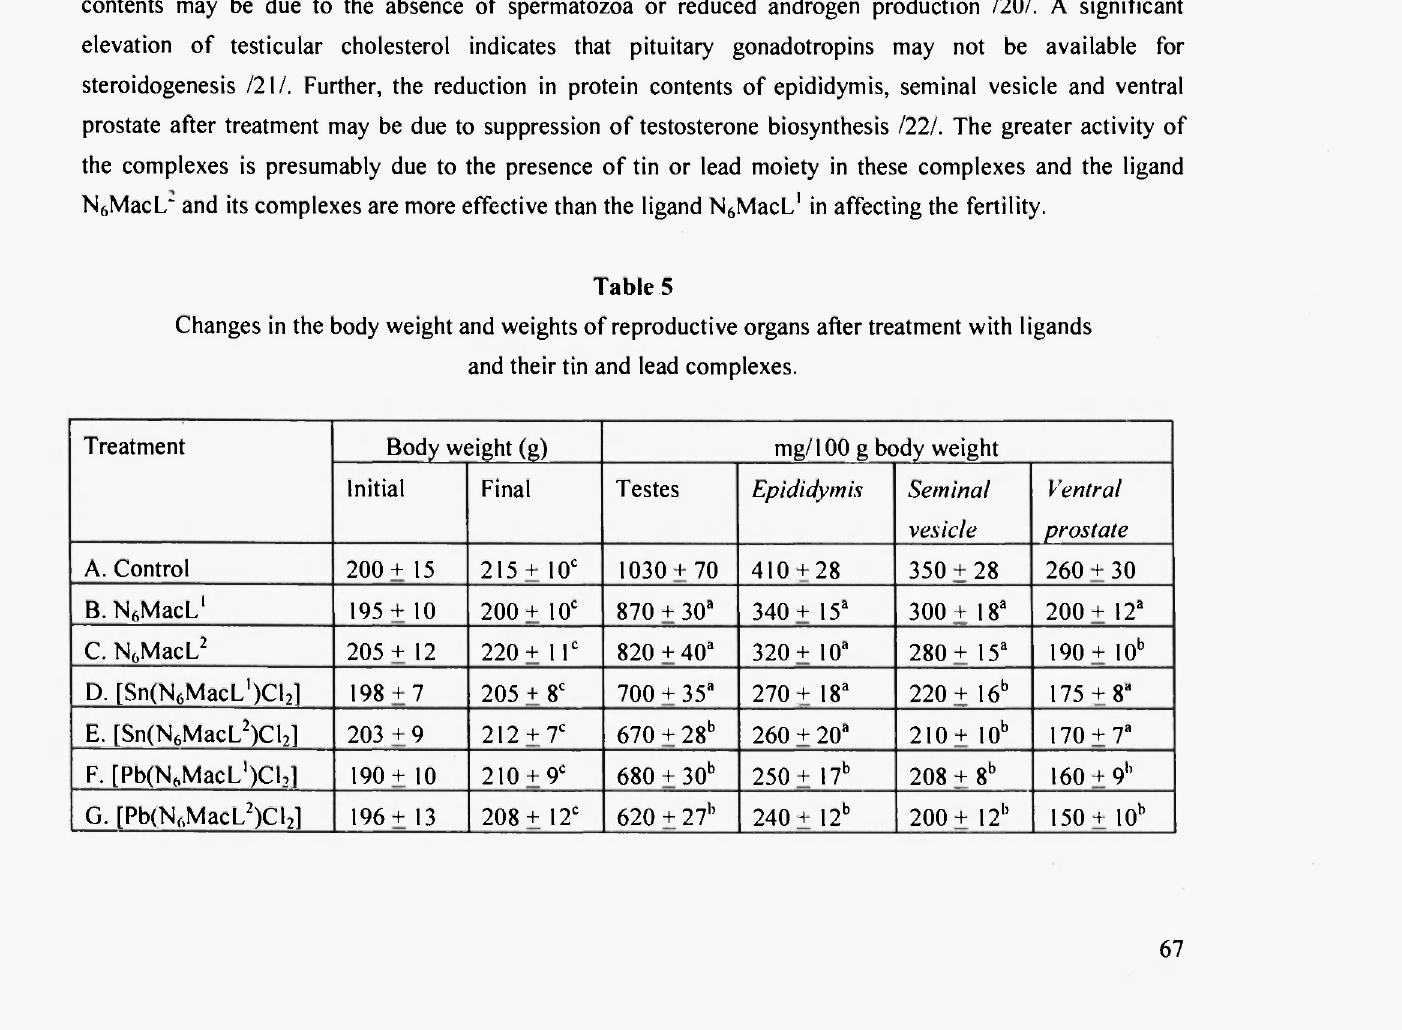
Changes in the body weight and weights of reproductive organs after treatment with ligands and their tin and lead